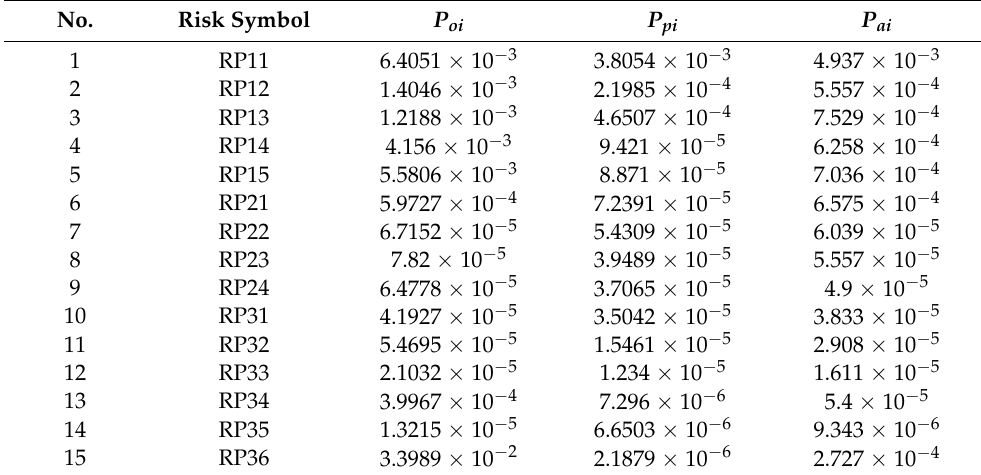
Table 6. High load risks probabilities of the space station configuration mission.